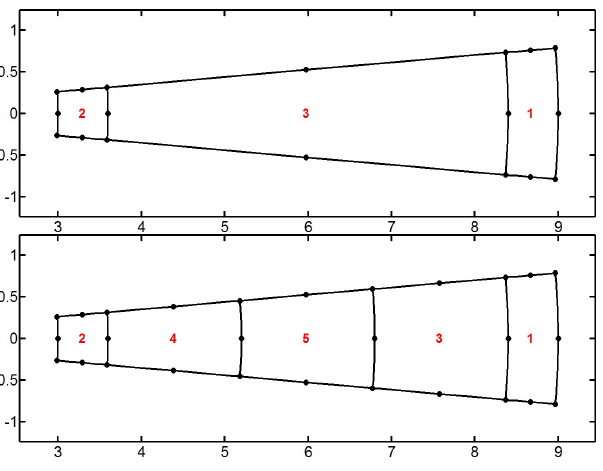
Figure 10: Composite thick-walled cylinder meshes used for the convergence computations.